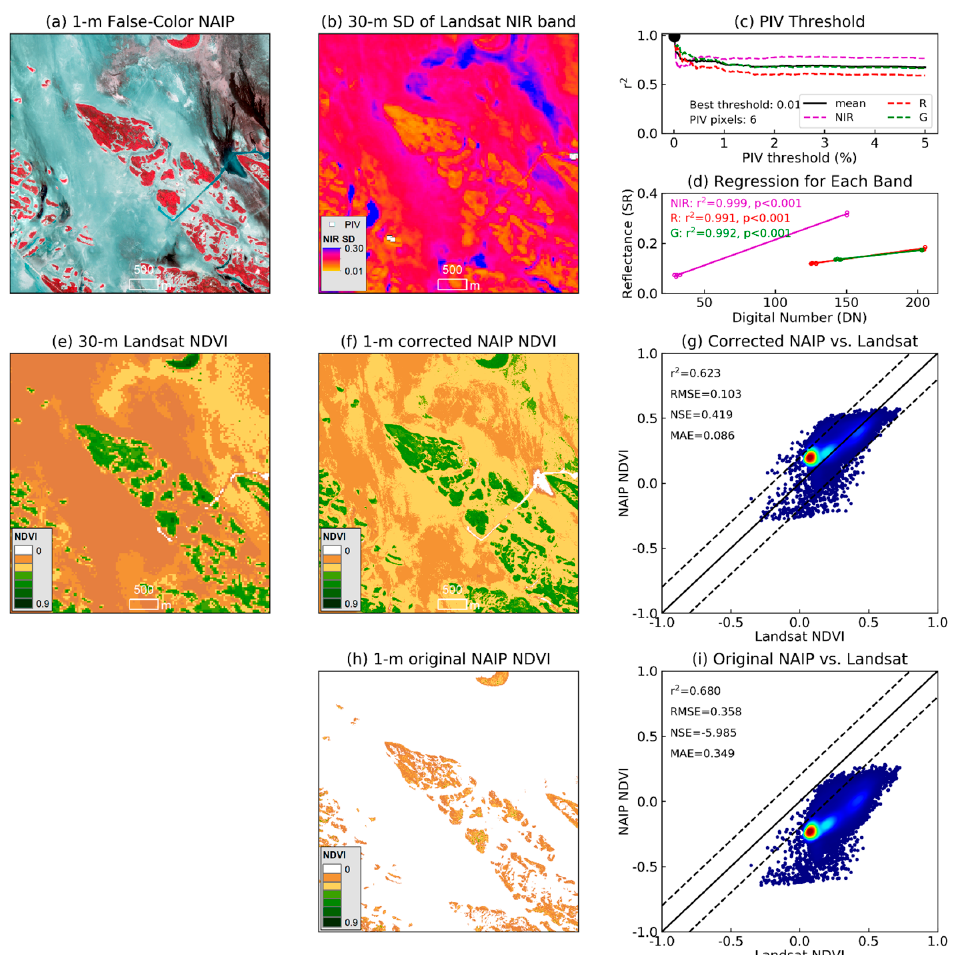
Figure 7. Application of PINT at site 4. Plots ( a )–( d ) demonstrate the identification of pseudoinvariant (PIV) pixels: plot ( a ) shows the 1 m false-color National Agriculture Imagery Program (NAIP) image (near-infrared (NIR), red and green bands) before radiometric correction; plot ( b ) shows pseudoinvariant features (white squares) identified from the 10 year NIR standard deviation of Landsat TM and ETM+ images; plot ( c ) demonstrates the identification of the best threshold (0.01st percentile); and plot ( d ) shows the linear regressions of Landsat surface reflectance and NAIP digital numbers based on pseudoinvariant pixels. Plots ( e )–( i ) show the validation of the normalized difference vegetation index (NDVI) values: plot ( e ) shows 30 m Landsat NDVI as the reference; plots ( f ) and ( h ) show 1 m NAIP NDVI before and after correction, respectively; and plots ( g ) and ( i ) show the agreement with Landsat reference before and after correction, respectively. The solid line is the 1:1 line, indicating a perfect match between NAIP and Landsat NDVI values, and the dashed lines represent the upper and lower 10% error bounds.